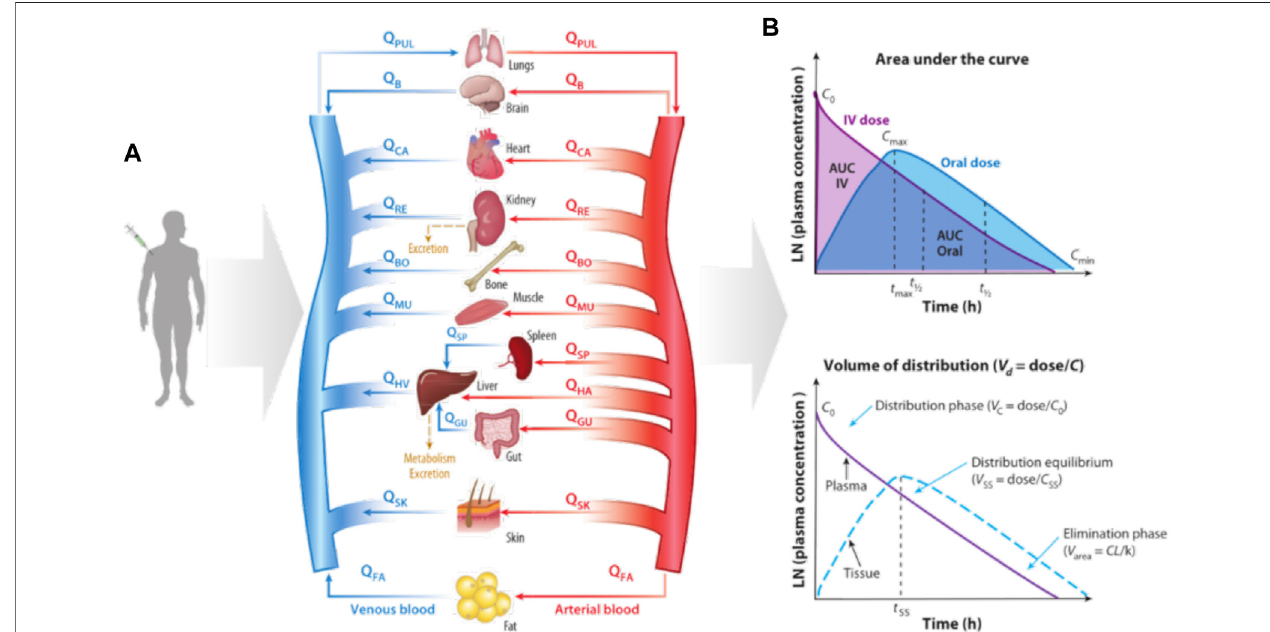
FIGURE 4 | Diagram of how organ size, composition, and blood fl ows (Q) are used to construct a physiologically based pharmacokinetic (PBPK) model of the wholebodyandpredictthekineticsofdrugexposure(Prantil-Baunetal.,2018). (A) HowaPBPKmodelcanbebuiltbasedonphysiologyknowledge; (B) Thecalculation of key PK